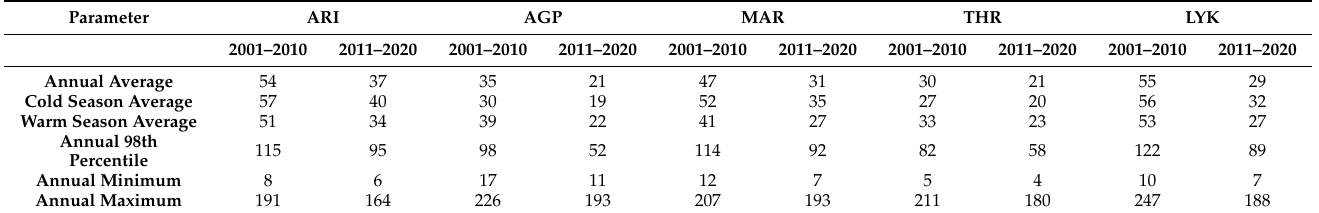
Table 2. Indicators for assessing the impact of PM 10 and the annual mean concentration ( µ gr/m 3 ) at each station for two periods (2001–2010,